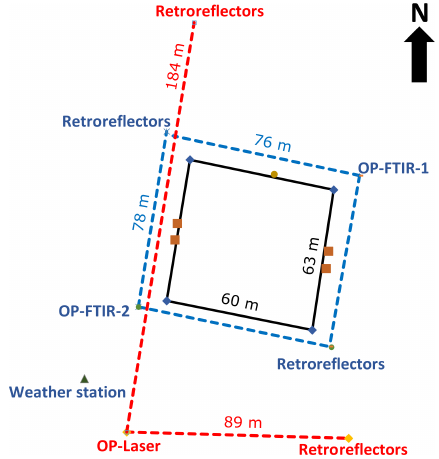
Figure 1. Schematic layout of the experimental site, showing an animal pen in the centre, two OP-FTIR systems (blue dashed lines), and the OP-Laser system (red dashed lines). Two feeding troughs (brown squares) were on both sides of the pen, and one water trough (brown circle) was on the northern side of the pen. A weather station (green triangle) was 50m away from the south-western corner of the